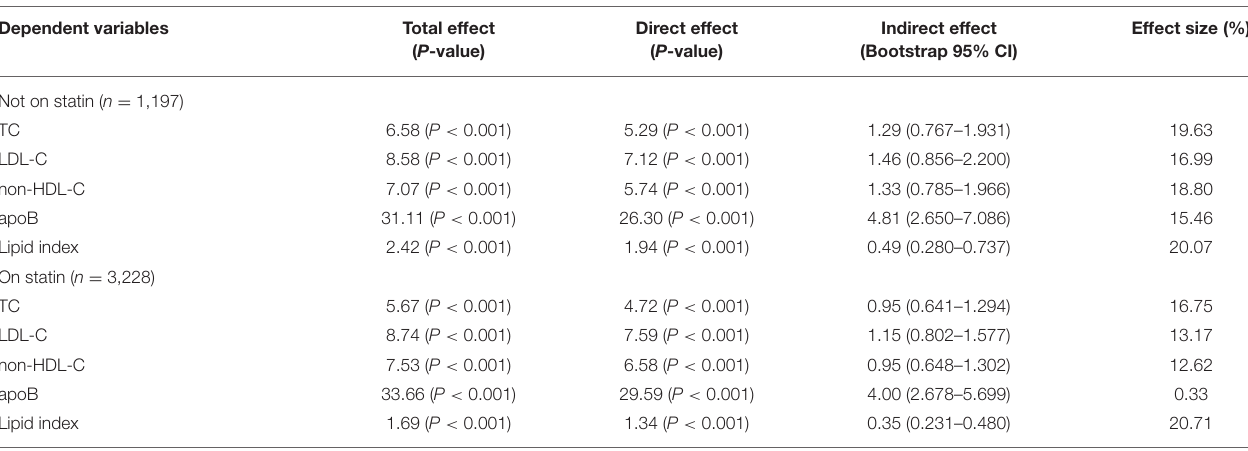
TABLE 7 | Mediation analysis for lipid parameters and GS via